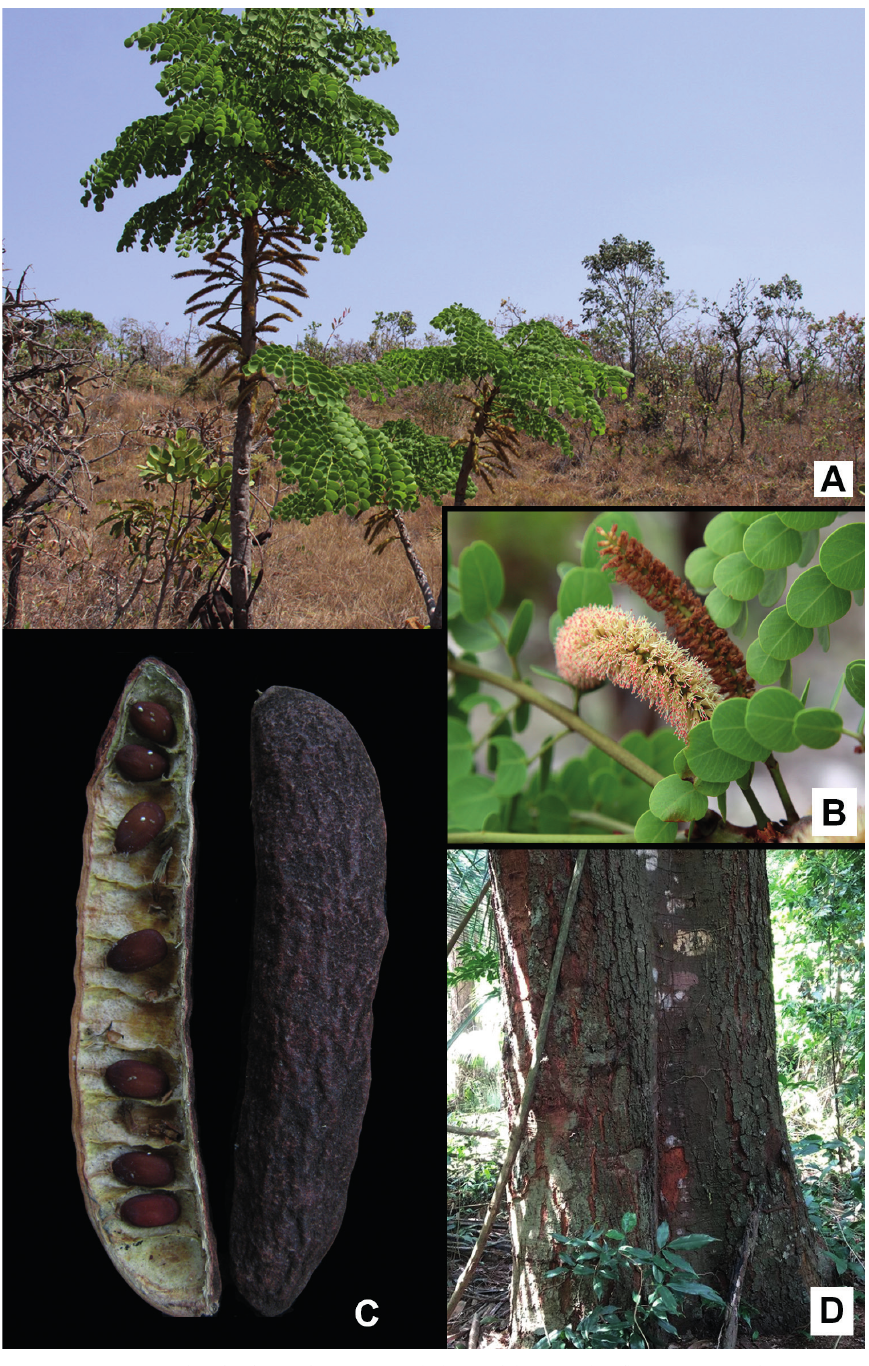
Figure 5. A, C Stryphnodendron adstringens : A habit B foliage and inflorescences C fruit (manually opened) and seeds D S. flavotomentosum : trunk and detail of bark. Photos: A, B Henrique Moreira C Marcelo Simon D Geovane